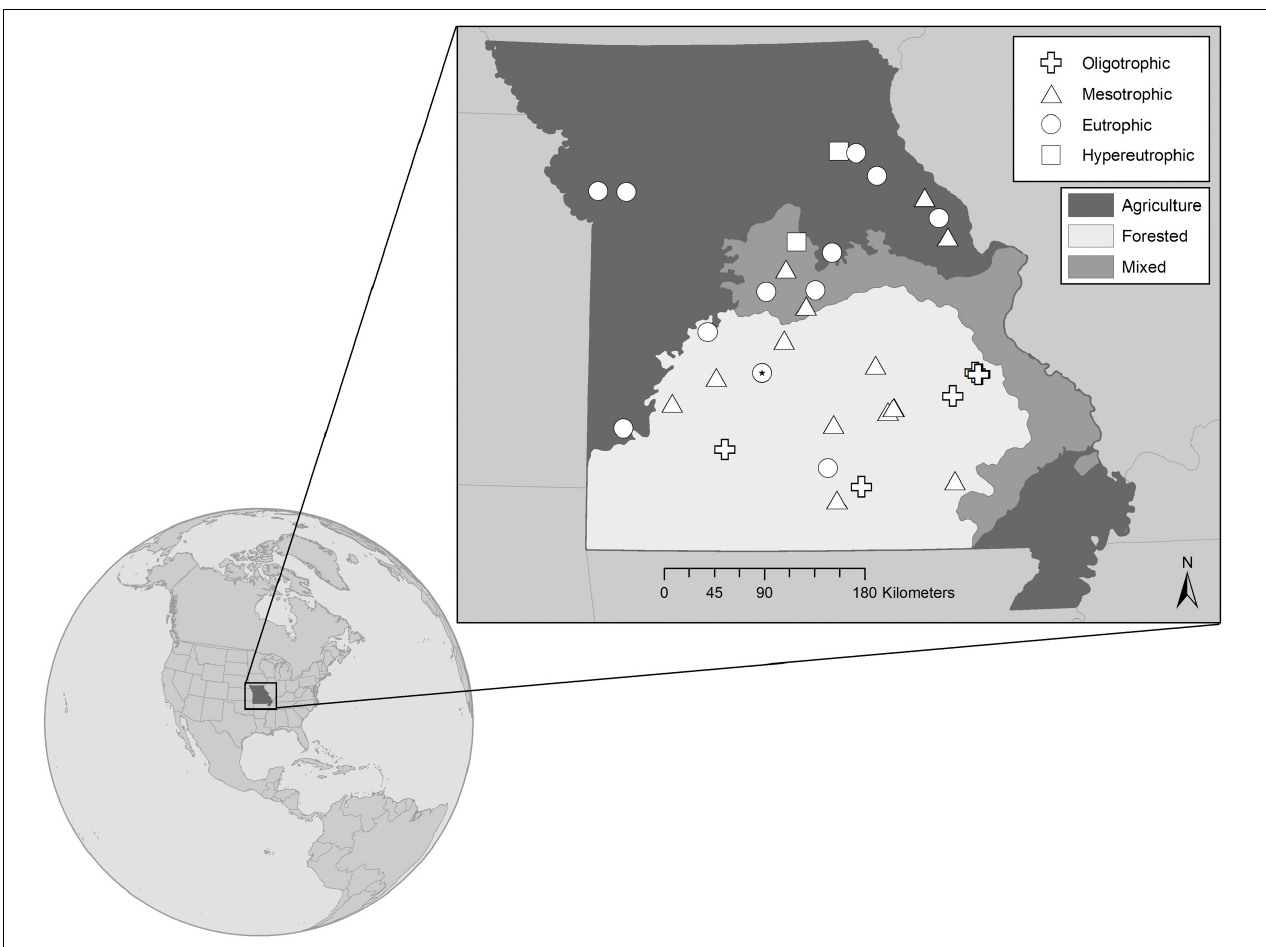
FIGURE 1 | Map showing the 32 reservoir study sites located in Missouri, United States. Sites represent the trophic gradient demonstrated by reservoirs throughout the state from very low ( ∼ 0.10 µ mol L - 1 ) to very high ( ∼ 4.40 µ mol L - 1 ) epilimnetic total phosphorus concentrations. Symbols distinguish trophic status, where represent oligo-, meso-, eu-, and hyper- trophic, respectively. All are warm monomictic, except for polymictic Niangua which is denoted as a eutrophic circle with a filled dot (*) in the center. Shading indicates the dominant land-use that has been generalized for each of the state’s major physiographic regions, with the north dominated by agriculture, the south largely forested, and mixed land cover in-between. Land-use specific to each reservoir’s watershed has been classified